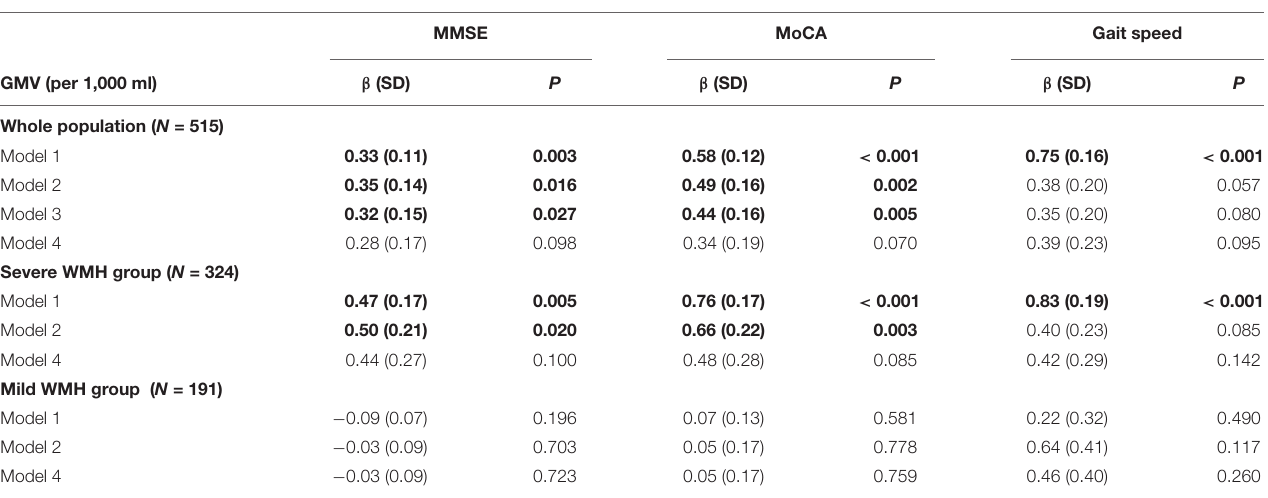
TABLE 7 | Relationship between GMV and cognitive function as well as gait